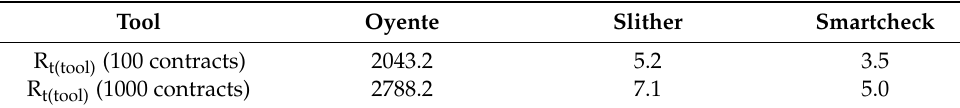
Table 7. The value of R t(tool) .